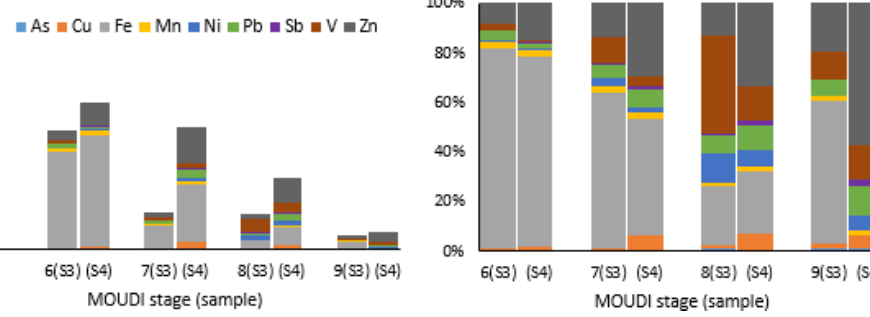
Figure 4. Elemental concentrations of (a) samples 1 (24h) and 2 (72h) in Ljubljana and (b) samples 3 (24h) and 4 (24h) in Martinska. Graphs on the left show atmospheric concentrations. Graphs on the right show corresponding percent composition. MOUDI stages 5–9 correspond to cut-point diameter of 1.0, 0.56, 0.32, 0.18, and 0.10µm,